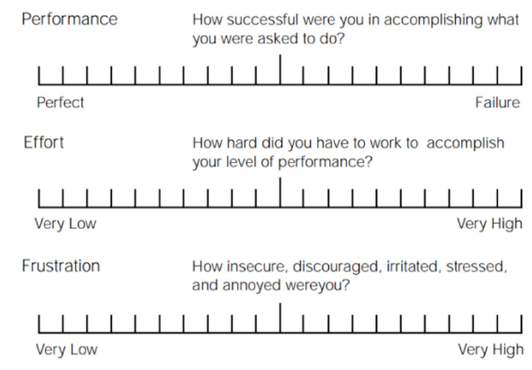
Figure 3. The NASA-TLX questionnaire.